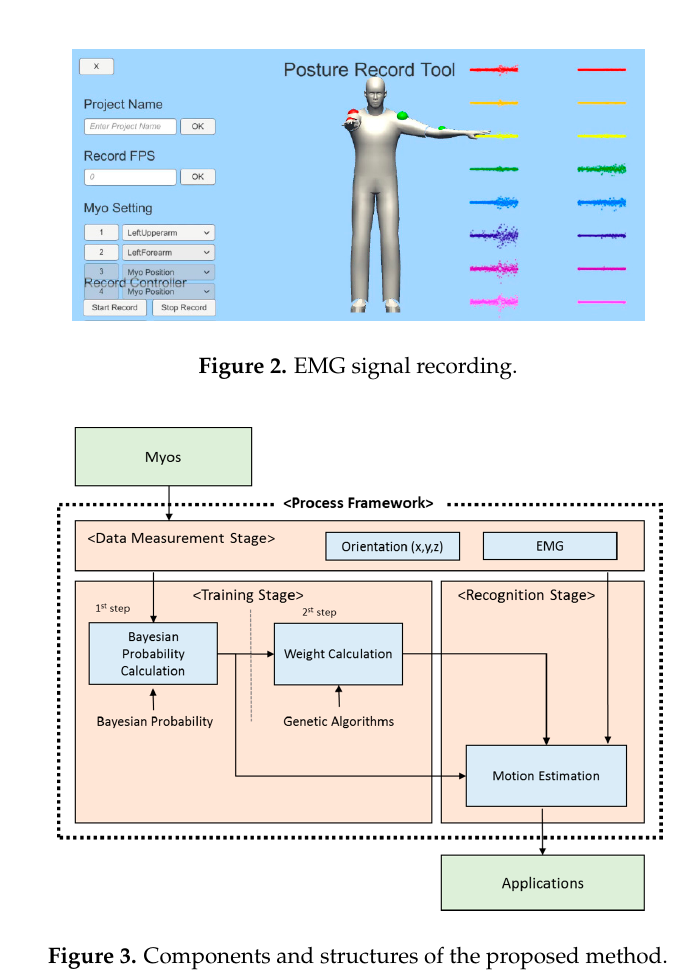
Figure 3. Components and structures of the proposed method.